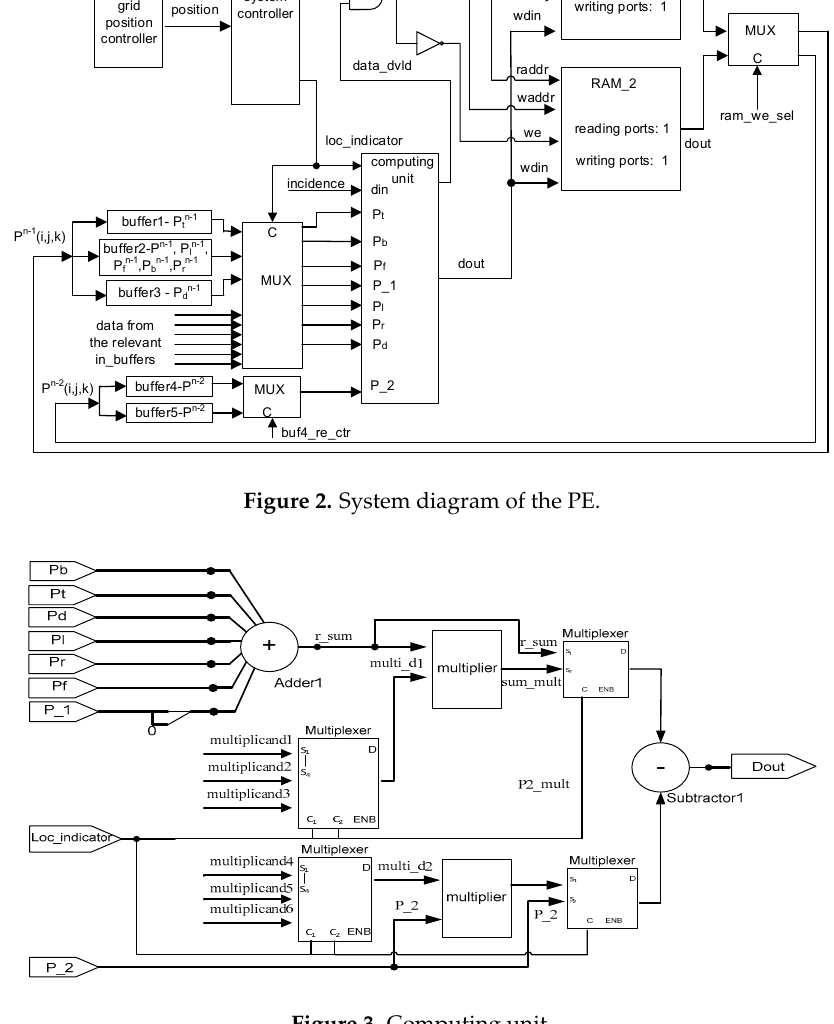
Figure 3. Computing unit.